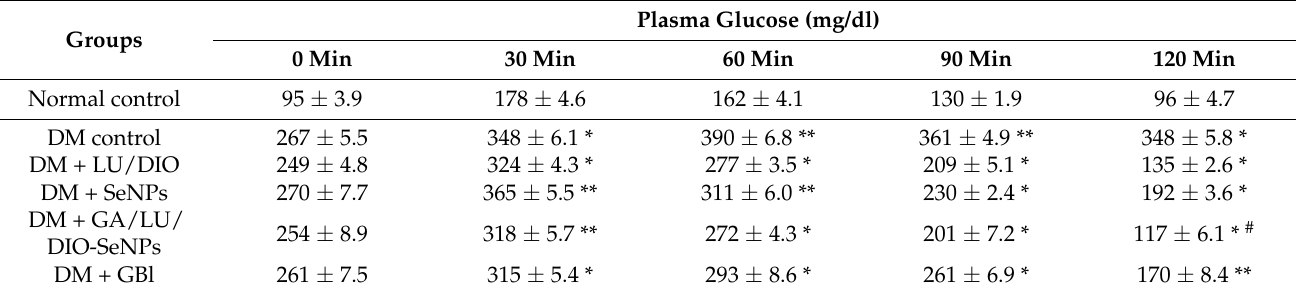
Table 4. Effect of LU/DIO, SeNPs GA/LU/DIO-SeNPs and on oral glucose tolerance assay (OGTTin diabetic mice.